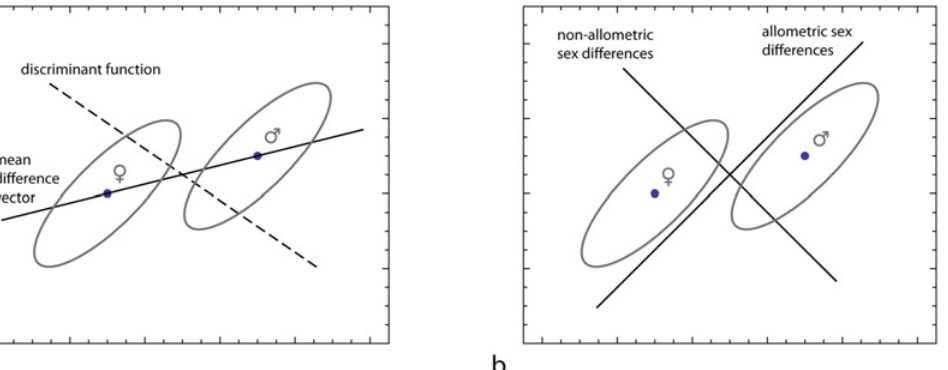
Fig 2. The statistical distribution of two morphometric variables for two groups of individuals (males and females) is shown by two equal frequency ellipses and the corresponding means. (a) The mean difference vector (solid line) is spanned by the two mean configurations. The discriminant function (dashed line) maximizes the squared distance between the group means relative to the variation of the scores within the groups. When the two covariance matrices are the same (as in this example), it is the optimal direction to discriminate the two groups and to classify individuals with unknown group membership. (b) The mean difference vector can be decomposed into an allometric component (which, for many morphometric data sets, is close to the direction of maximum variance within the groups) and a non-allometric component (orthogonal to the allometric direction).